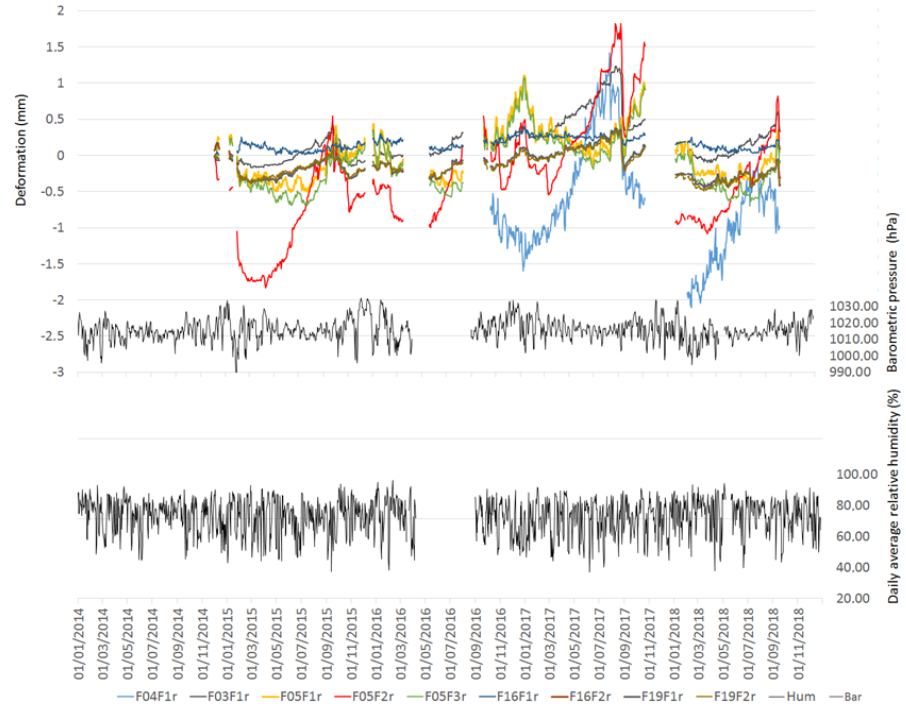
Figure 24. Comparison between crackmeter measurements, relative humidity and daily barometric pressure) data time series.